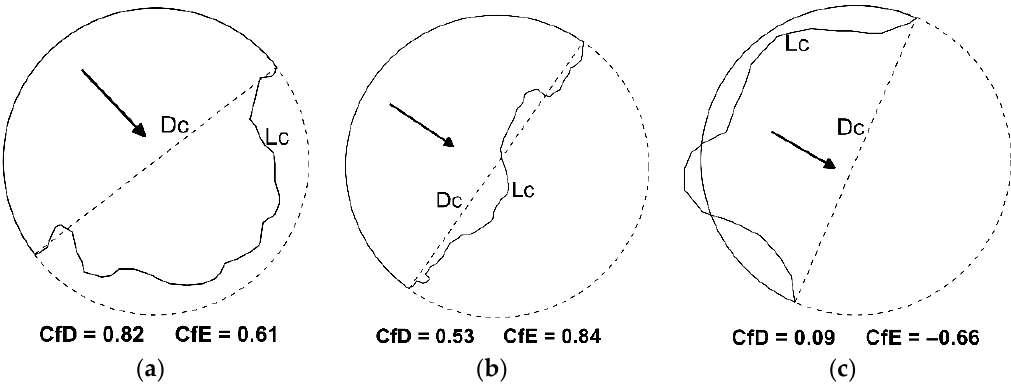
Figure 2. Examples of the shape of the frontal zone expressed by CfD and CfE indicators depending on the dynamic state of a tidewater glacier: ( a ) Advancing glacier; ( b ) Glacier in the momentary equilibrium state; and ( c ) Glacier undergoing recession. An arrow points the glacier flow direction.